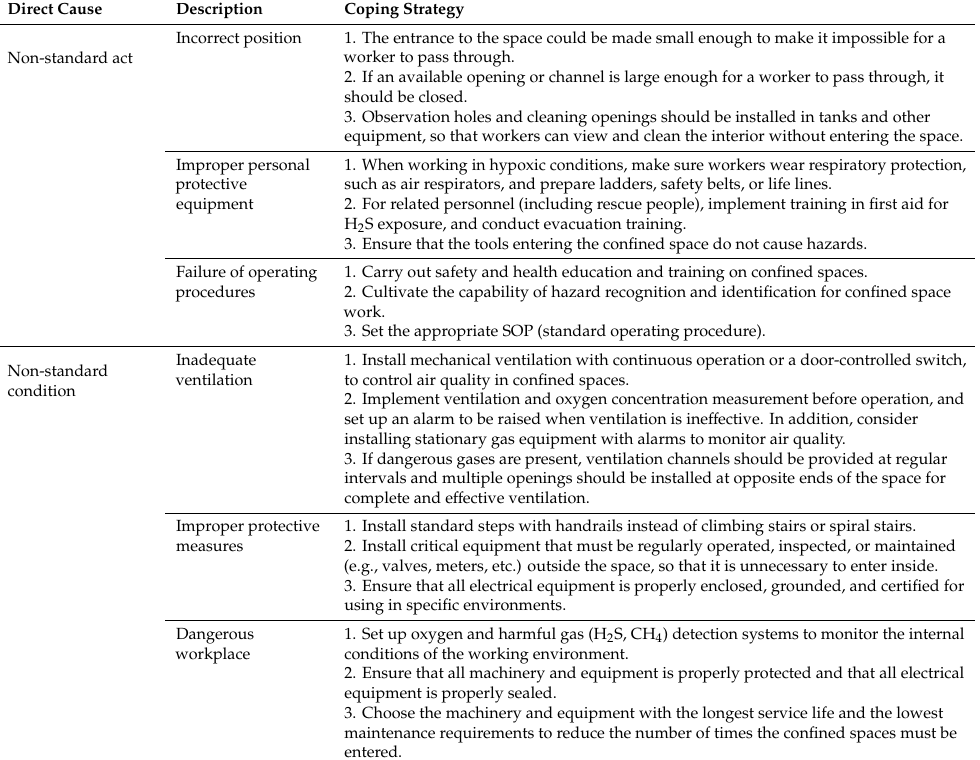
Table 6. Coping strategies for preventing confined space accidents due to hydrogen